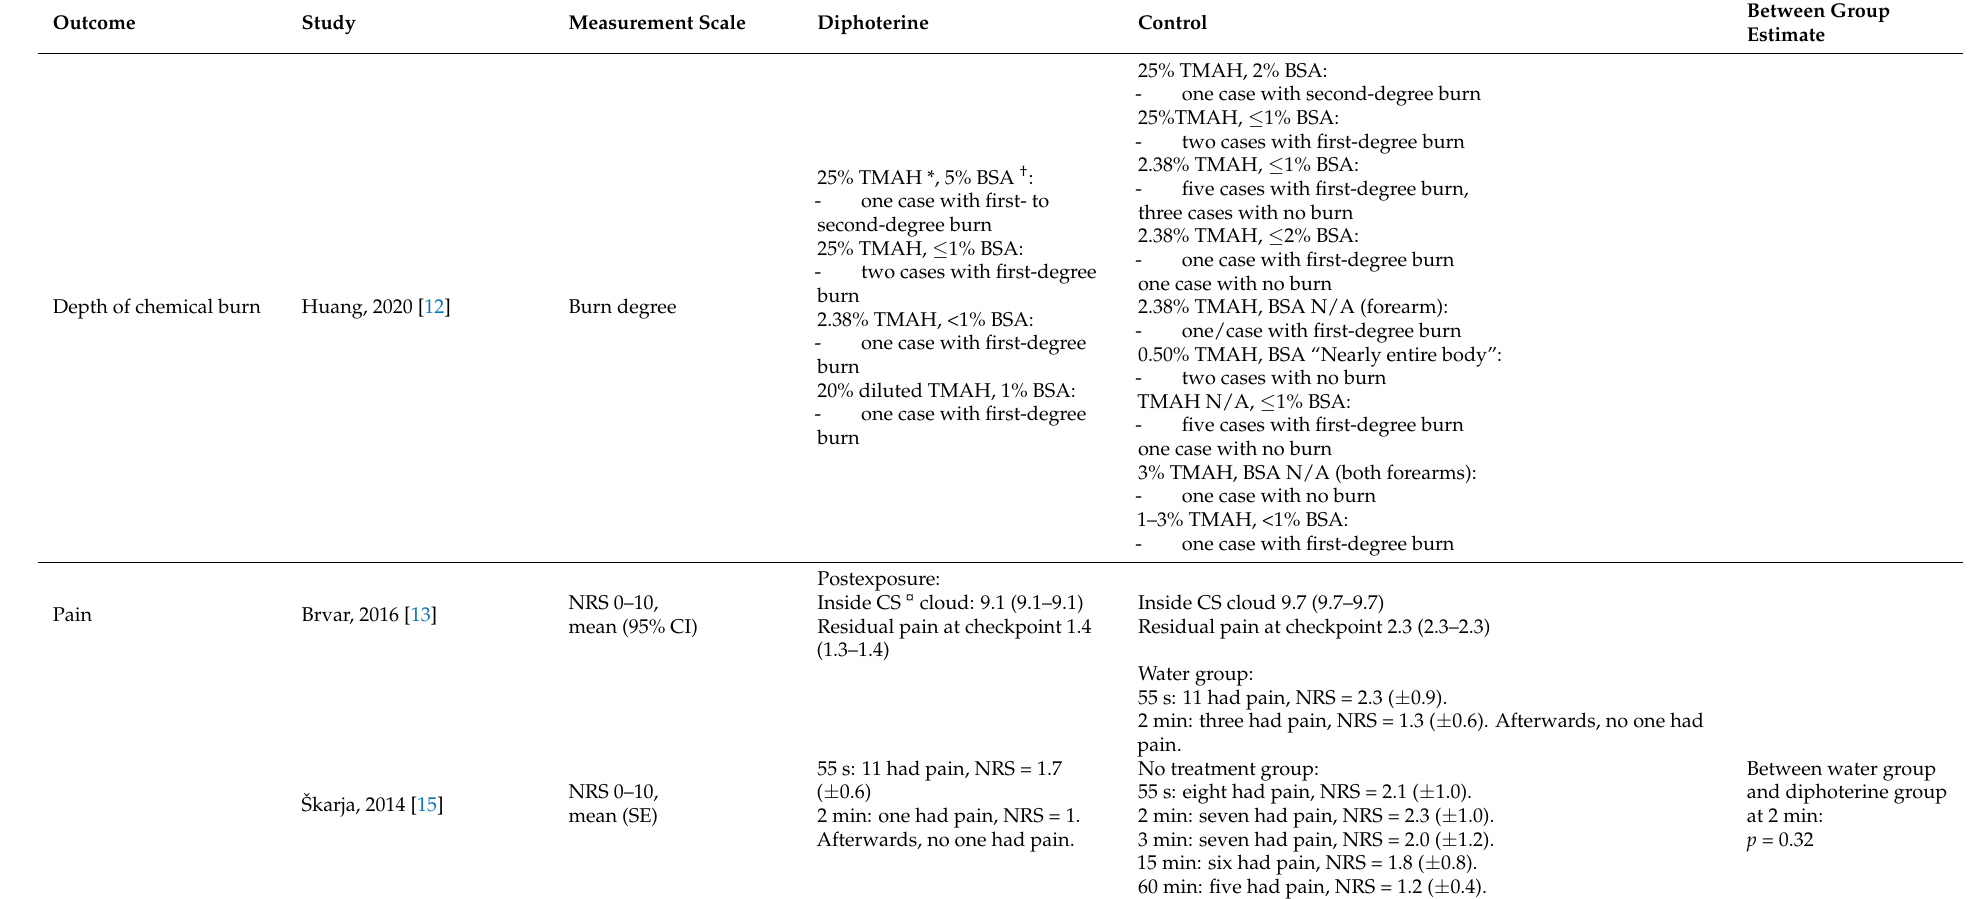
Table 2. Outcomes from studies assessing diphoterine compared with water or no treatment for chemical burns of the skin. Outcome